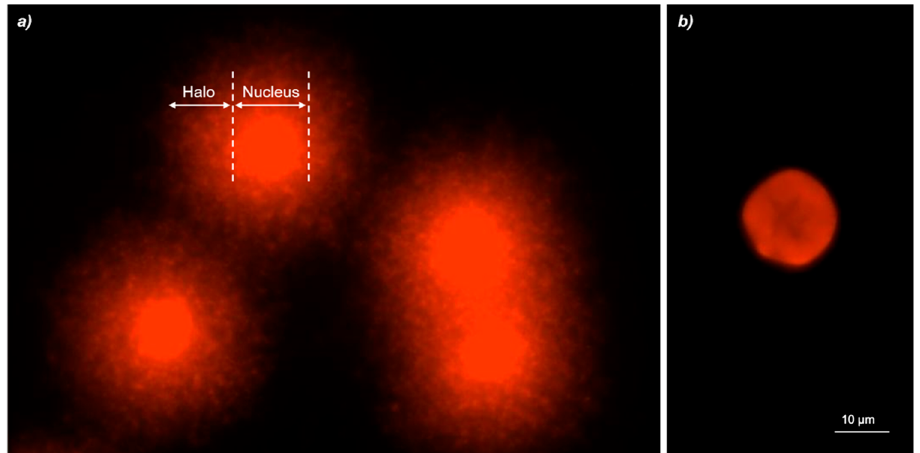
Figure 5. ( a ) Apoptotic zebrafish blood cells analyzed with Nikon Eclipse E-600 microscope. ( b ) Negative control zebrafish blood cell analyzed with Nikon Eclipse E-600 microscope.